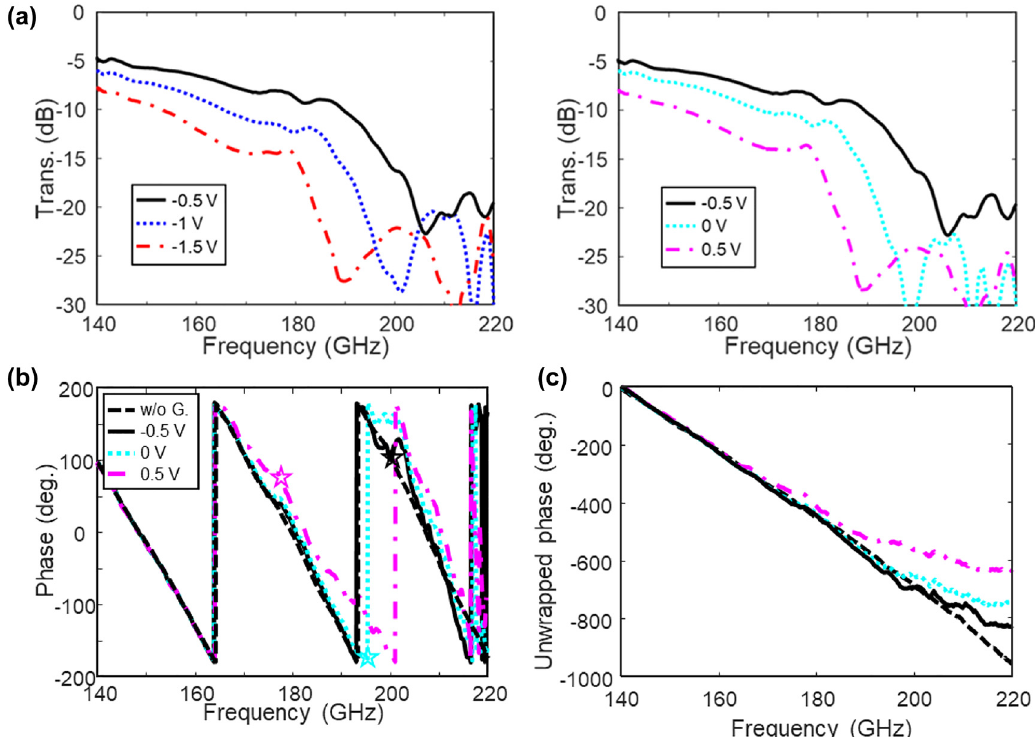
Figure 5: Measured (a) transmittance, (b) wrapped phase, and (c) normalized unwrapped phase under various bias